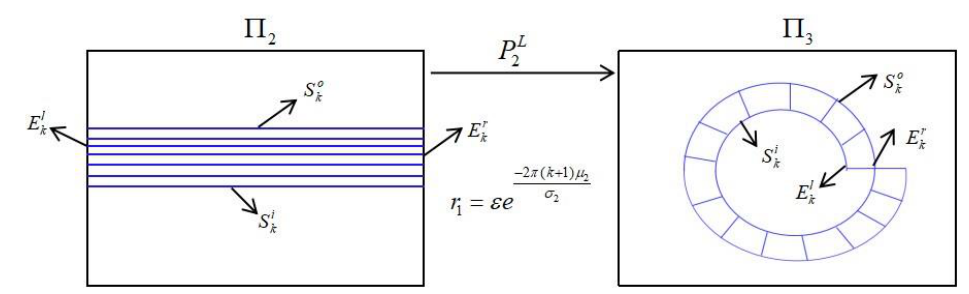
Figure 11. The process of from a planar linear structure to a logarithmic spiral structure.